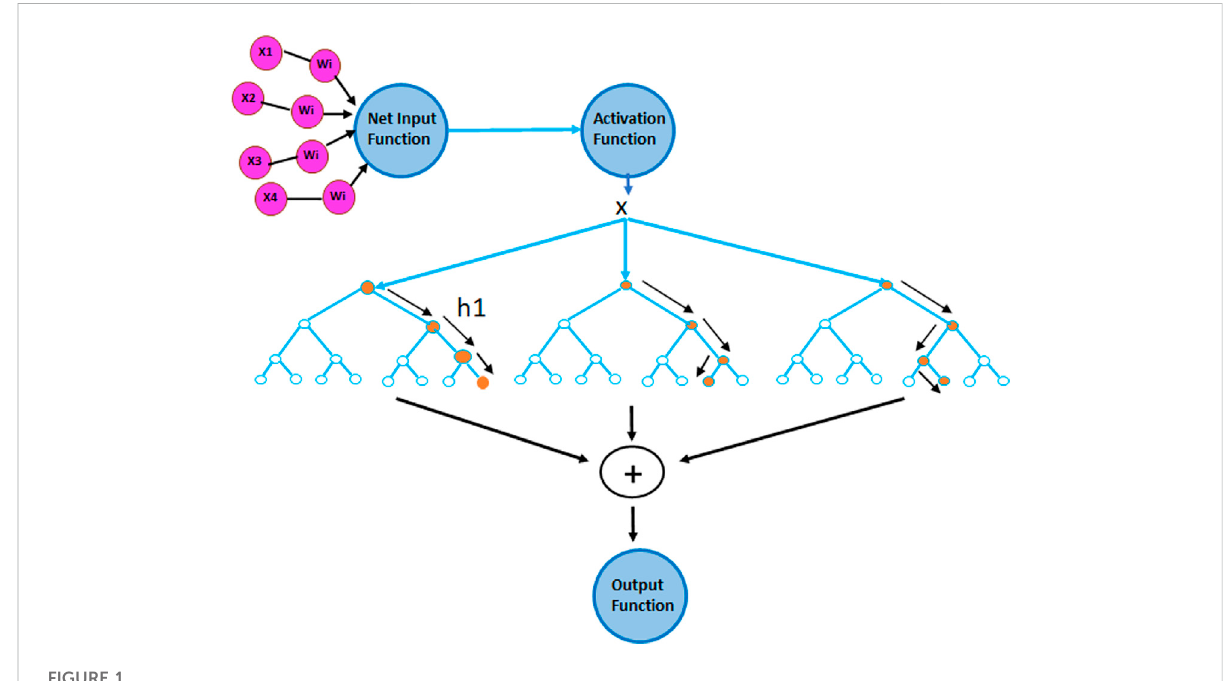
FIGURE 1 Hybrid classi fi er (SVM-GBC classi fi cation) model.